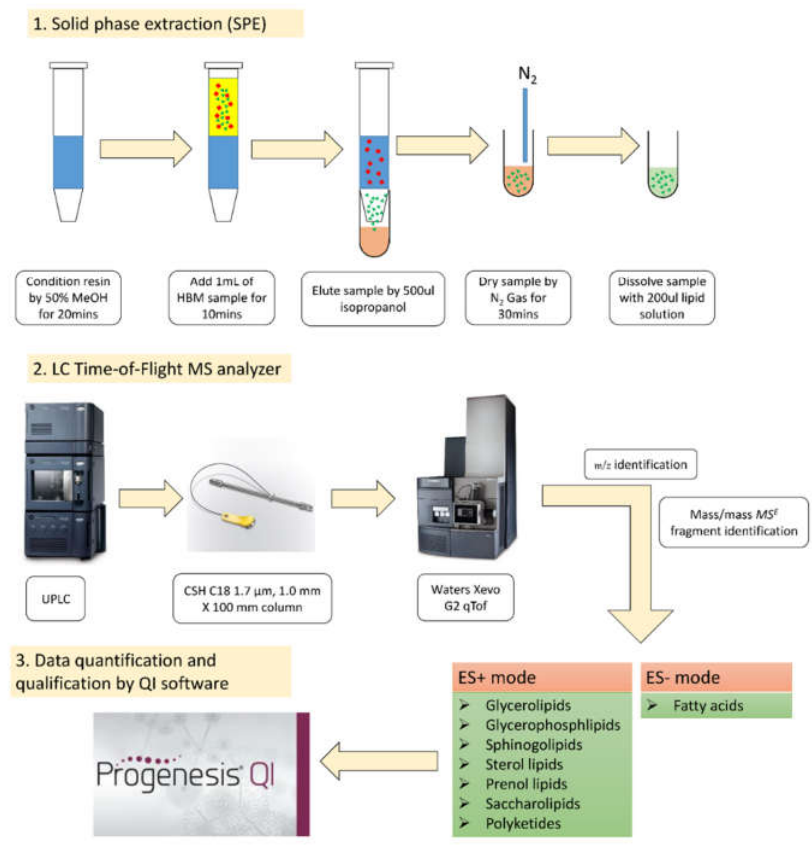
Figure 1. Steps of lipidomics analyses.